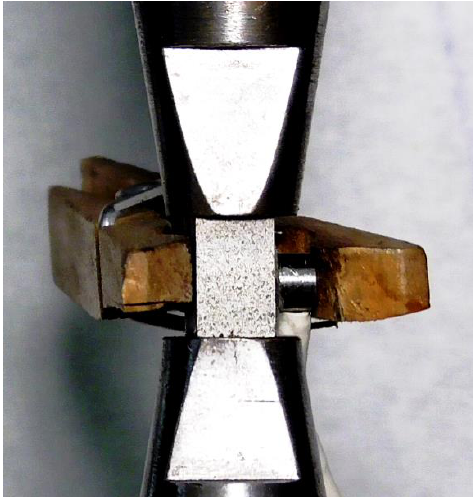
Figure 3. Picture of the experimental setup and mounting of the AE sensor.